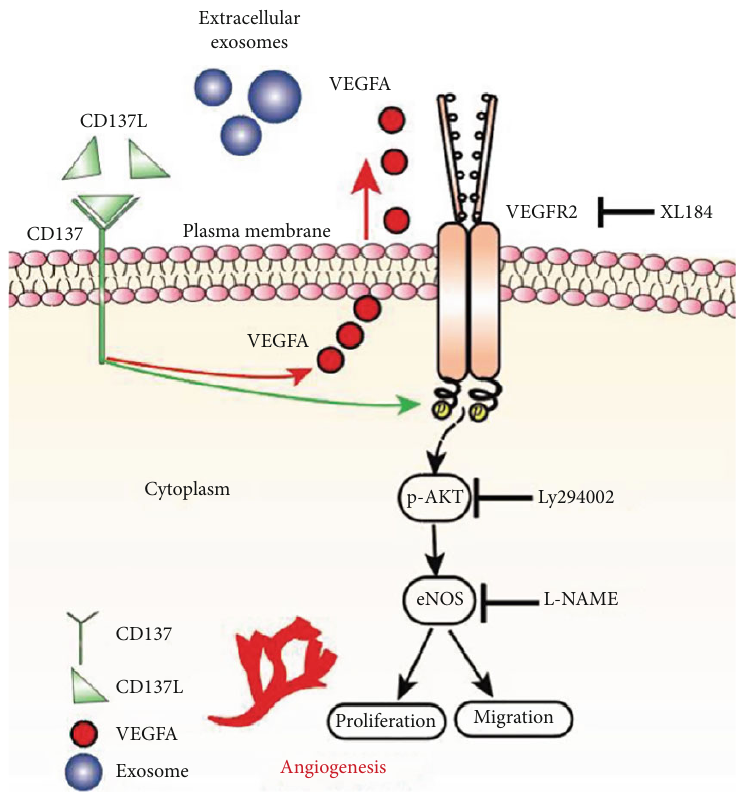
Figure 8: Graphical abstract. Activation of CD137 signaling promoted sprouting angiogenesis via increased VEGFA secretion and the VEGFR2/Akt/eNOS pathway. CD137 upregulated the expression of VEGFR2 on the fi lopodia of migrating endothelial cells to sense VEGFA in the milieu. Therefore, increased VEGFA secretion together with the VEGFR2 activation induced downstream Akt/eNOS transduction, leading to proliferation, migration, and